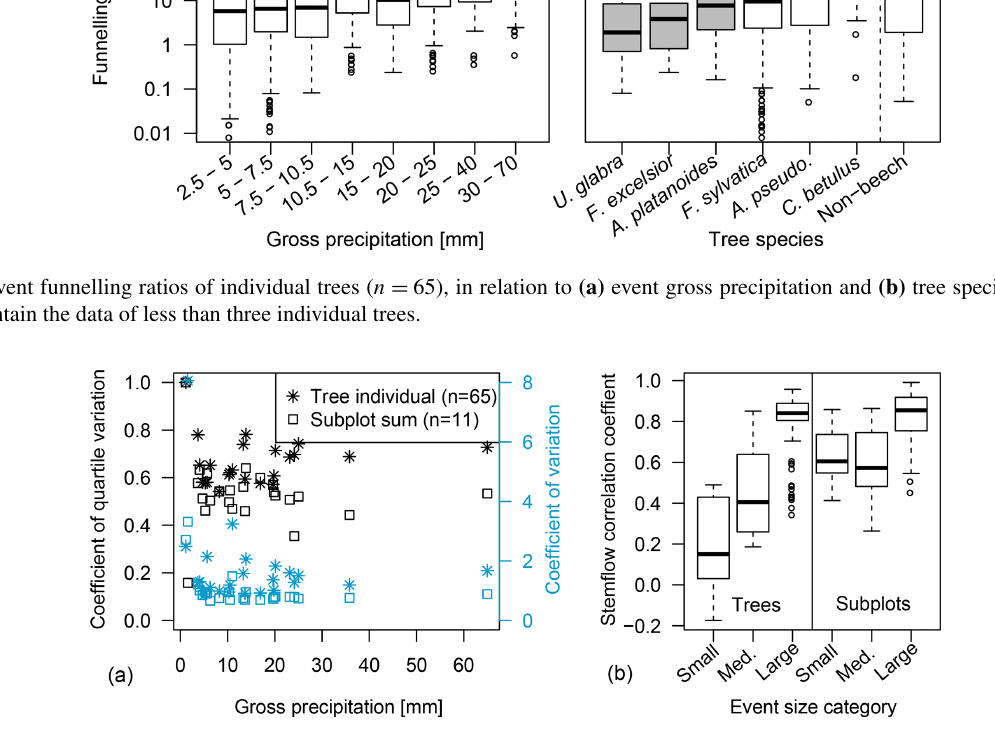
Figure 5. (a) Coefficients of quartile variation and coefficients of variation for stemflow of individual trees as well as subplots for all recorded precipitation events in relation to gross precipitation. (b) Temporal stability of stemflow on the tree scale and the subplot scale, calculated as pairwise correlation coefficients (Spearman) of tree/subplot stemflow between all of the different precipitation events of one event size